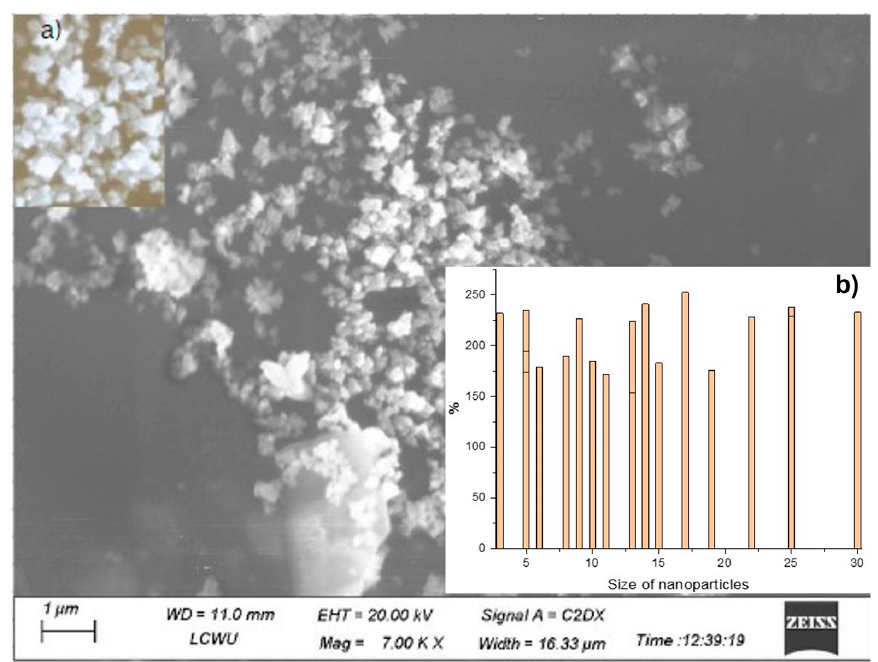
Figure 4. SEM images of ZnO NPs: ( a ) shows the ZnO NPs; ( b ) shows the size distribution of NPs.